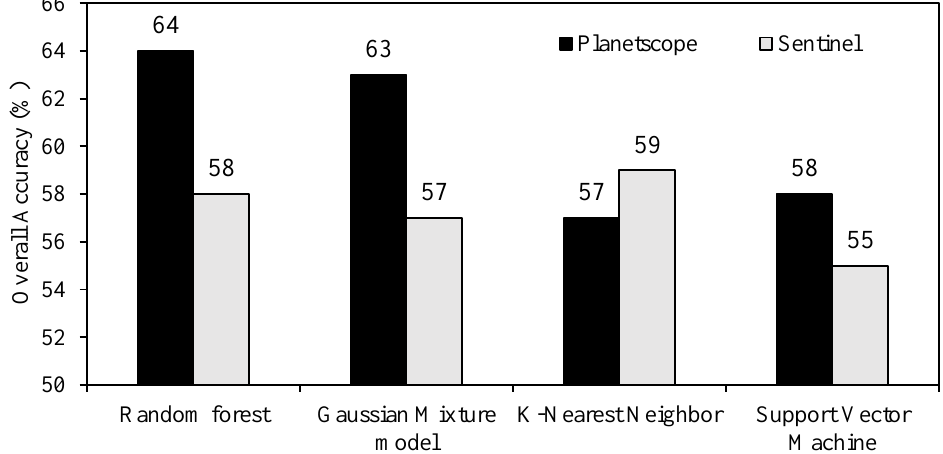
Figure 7. Graphical representation of overall accuracy of all ML algorithms with PlanetScope and Sentinel-2 data.